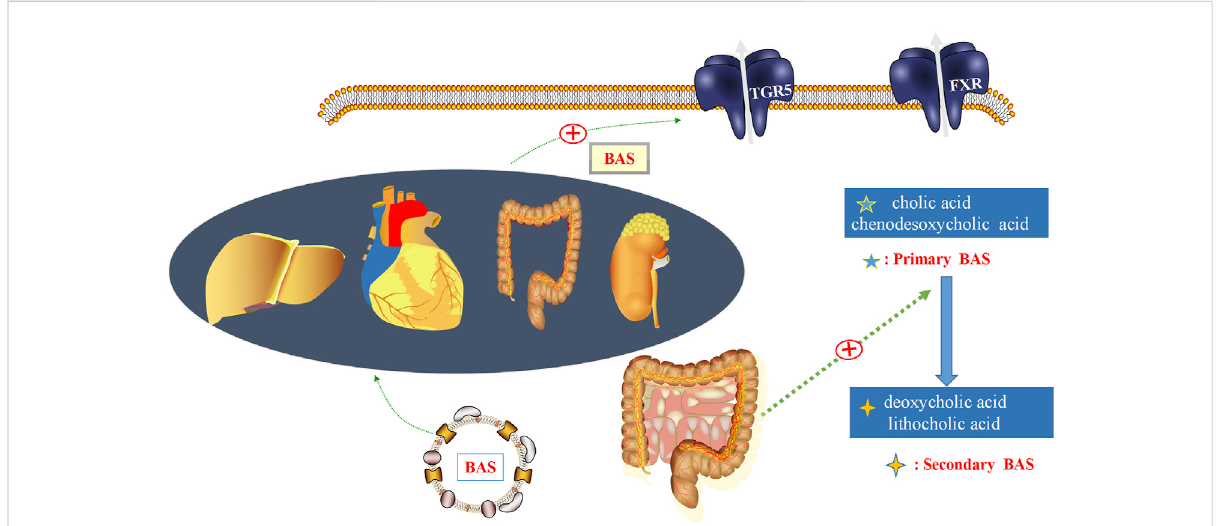
FIGURE 1 Gut microbiota and bile acids (BAs). In the gut, BAs are a detergent required for the formation of mixed micelles, dissolution, and digestion. BAs regulate metabolic homeostasis by activating BA receptors, such as G protein-coupled bile acid receptor 1 (TGR5), which are expressed in the intestinal tract, heart, liver, kidney, and other organs. Primary bile acids, such as cholic acid and chenodesoxycholic acid, could be converted into secondary BAs, including deoxycholic acid and lithocholic acid, under the regulation of gut